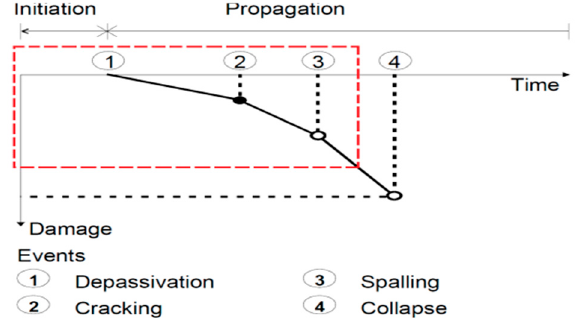
Figure 11. Events during a service life.